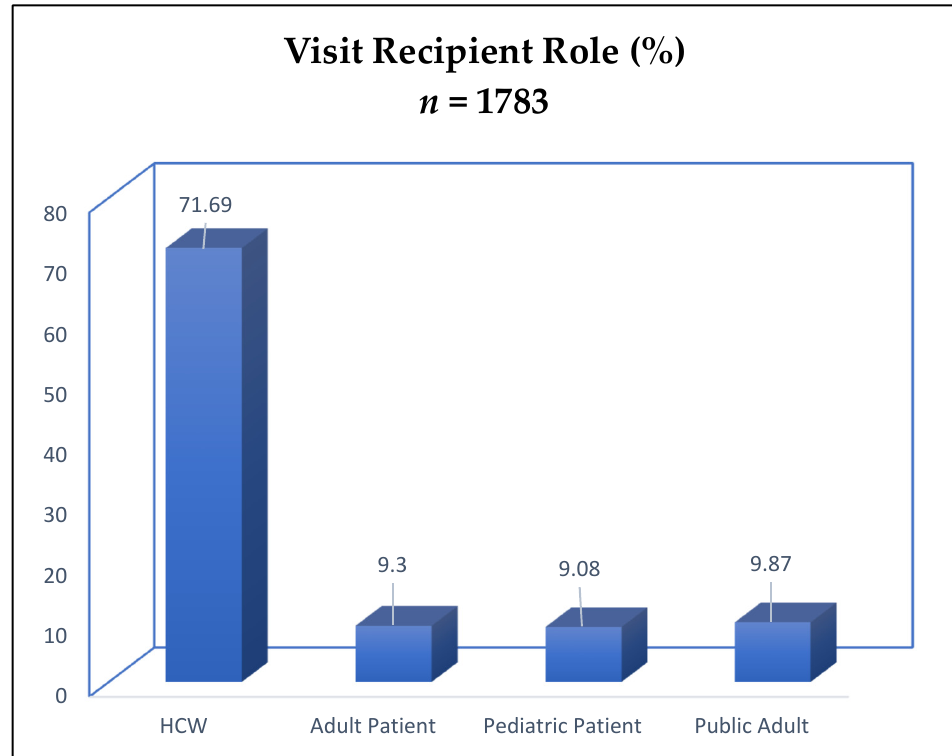
Figure 1. Visit recipient roles as percentage of visit recipients.